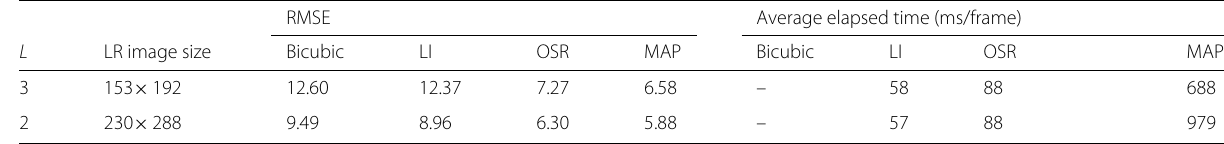
Table 1 Comparison of performance of different SR methods in RMSE and elapsed time